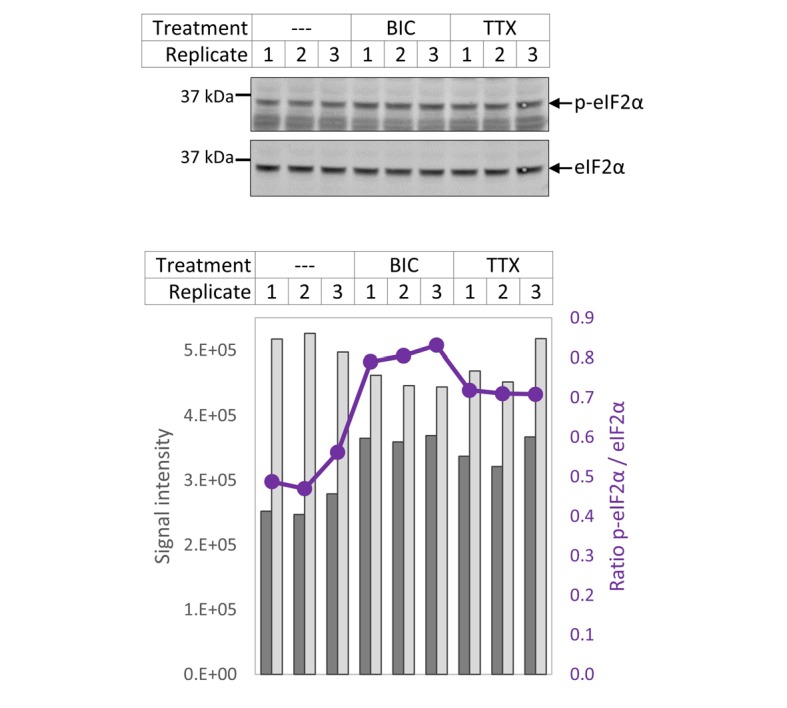
eIF2α phosphorylation.Quantification of p-eIF2α and unmodified eIF2α via western blot.